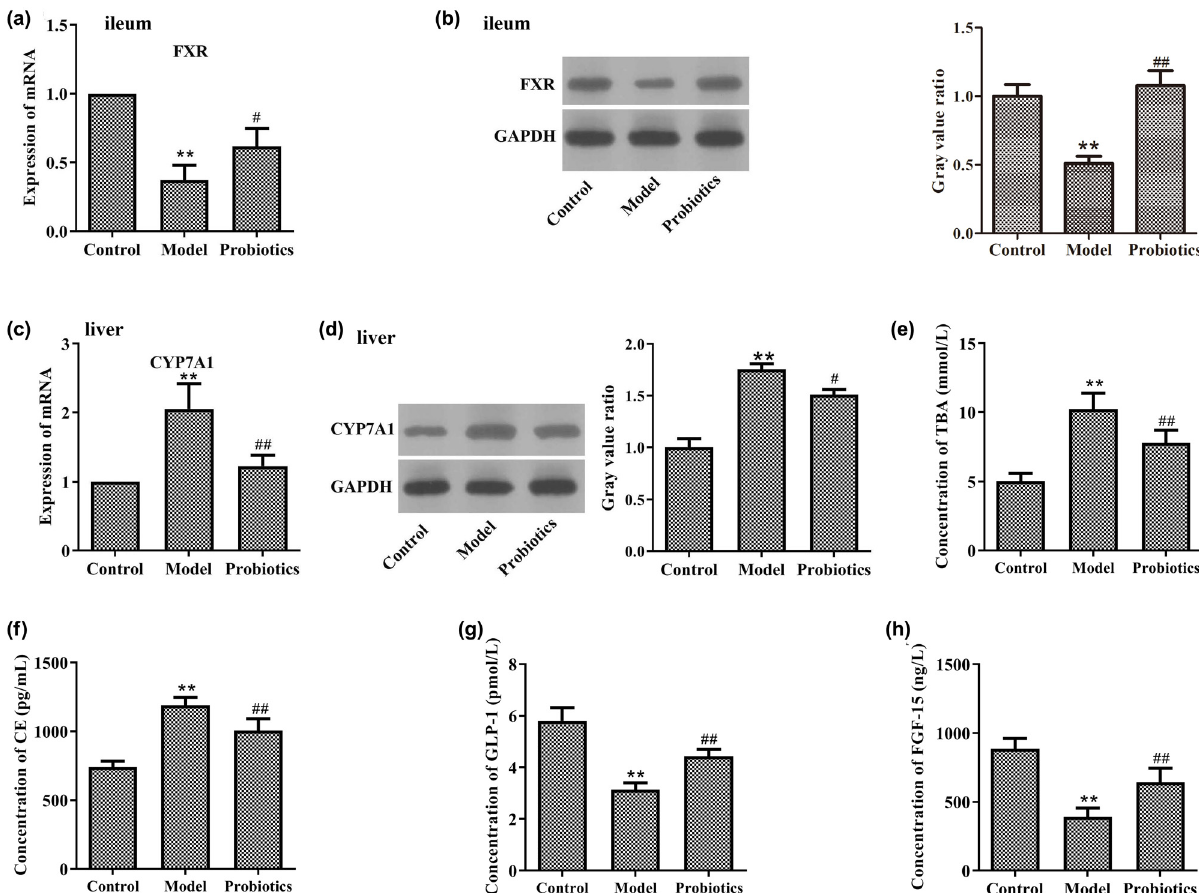
Figure 5: The levels of FXR and CYP7A1 in liver and ileum were analyzed by qPCR and western blot assays, and the blood biochemical indexes were detected after the addition of Probio - M8 in T2DM mice. ( a and b ) The level of FXR was reduced in ileum of T2DM mice, whereas the addition of Probio - M8 altered the condition. ( c and d ) The level of CYP7A1 in liver of T2DM mice was increased; however, the addition of Probio - M8 eliminated the phenomenon. ( e ) The increase level of TBA in T2DM mice was eliminated by the addition of Probio - M8. ( f ) The increase level of CE in T2DM mice was eliminated by the addition of Probio - M8. ( g and h ) The reduced levels of GLP - 1 and FGF - 15 in T2DM mice were eliminated by the addition of Probio - M8. ** P < 0.01 vs control, ## P < 0.01 vs